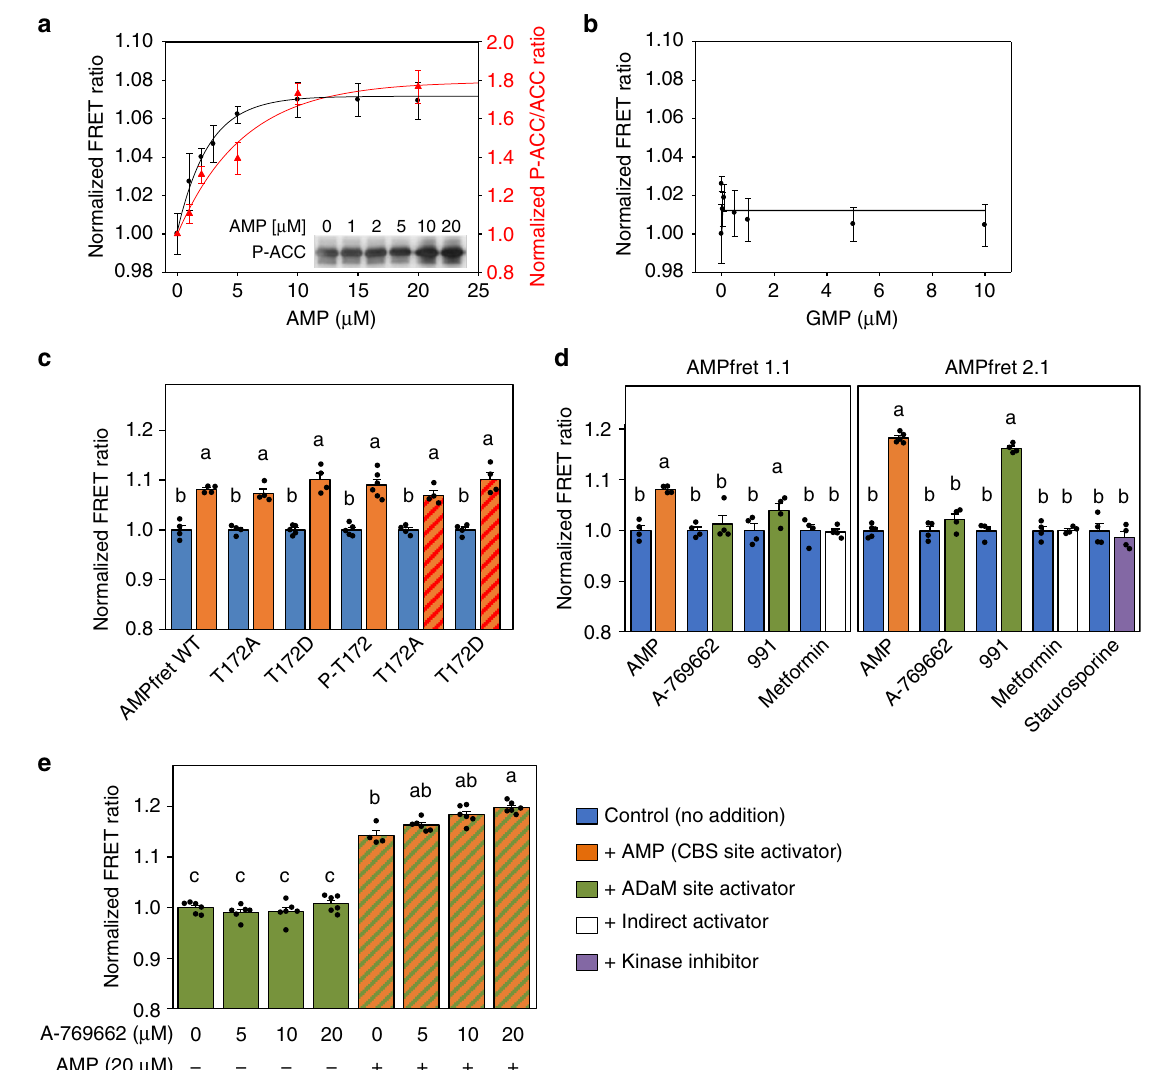
Fig. 2 FRET changes report AMPK allosteric activation. a AMP-concentration dependence of FRET (black) compared to AMP-induced allosteric activation (red) of AMPfret 1.0. This activation was determined with pre-activated AMPK in presence of 200 µ M ATP, followed by immunoblotting for phosphorylated acetyl-CoA carboxylase (ACC; insert); quanti fi ed band intensities were normalized to control at 0 µ M AMP. Data and error bars represent mean ± SEM ( n ≥ 3). Note: ATP in the kinase assay shifts the curve to higher AMP concentrations. b GMP-concentration dependence of FRET, showing absence of FRET change. Points represent mean ± SEM ( n ≥ 3). c Phosphorylation of T172 does not interfere with AMP-induced conformational changes reported by FRET. AMPfret 1.0 wild type (WT), pre-phosphorylated (P-T172), or mutated (T172A/D) proteins were incubated in absence (blue) or in presence of 20 µ M AMP (orange), or with additional 3 mM Mg 2 + -complexed ATP (orange dashed red). Note: FRET changes are independent of MgATP. Data and error bars represent mean ± SEM ( n ≥ 3). d AMPfret response to different AMPK activators. AMPfret 1.1 (left) or 2.1 (right) were incubated in absence (blue) or in presence of AMP (20 µ M, orange), A-769662 (20 µ M, green), 991 (2 µ M, green), metformin (500 µ M, white) or staurosporine (25 µ M, purple). Note: no FRET change is induced by the indirect activator metformin or the protein kinase inhibitor staurosporine. Data and error bars represent mean ± SEM ( n ≥ 4). e Additive effect of allosteric activators bound to CBS (AMP) and ADaM sites (A-769662). FRET ratio of AMPfret 2.0 incubated with A-769662 (5 – 20 µ M) in absence (green) or presence of 20 µ M AMP (green dashed orange). Note: a concentration-dependent effect of A- 769662 is only signi fi cant in presence of AMP. Data and error bars represent mean ± SEM ( n ≥ 3). All FRET signals are normalized to control (no adenylates). After checking normality and equality of variance, statistical signi fi cance was analysed by two-way ANOVA followed by Bonferroni multiple comparison. Means sharing the same letter do not differ signi fi cantly ( p ≤